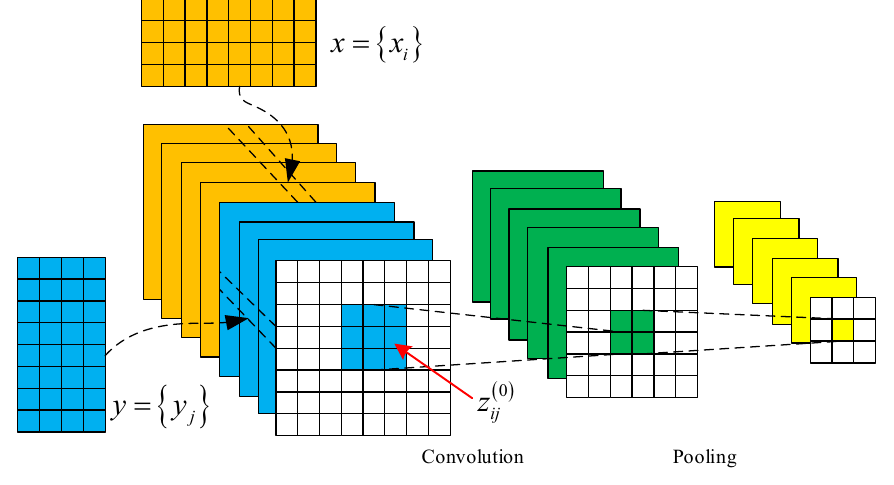
Figure 4: Discriminator structure of confrontation network